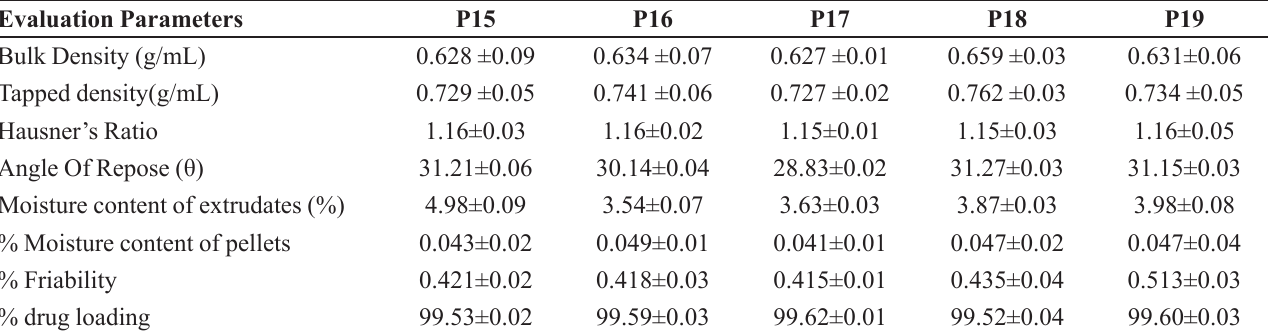
TABLE V - Evaluation parameters of the methotrexate core pellets Evaluation